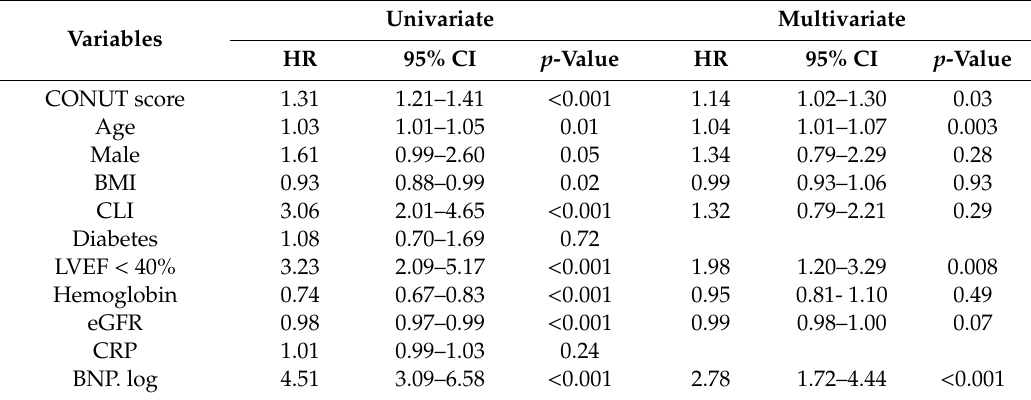
Table 2. Univariate and multivariate analyses of any